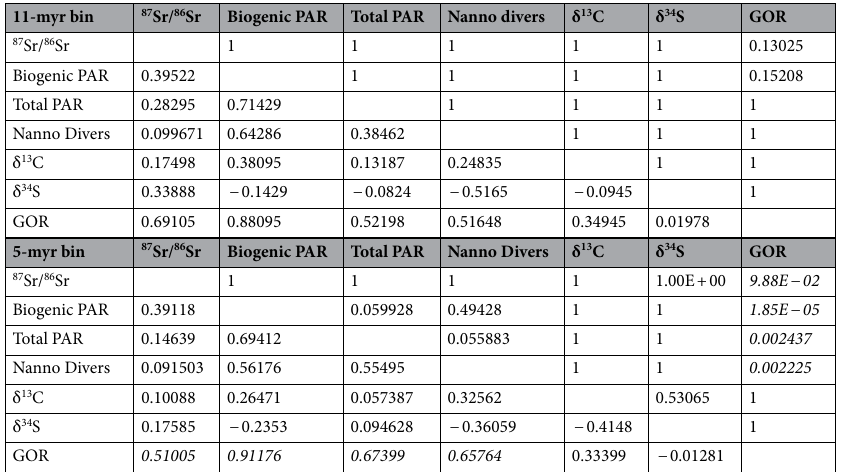
Table 2. Comparison of correlations omitting CO 2 and sea level using Bonferroni correction*. *Bonferroni correction set to p < 0.0024 (see Methods). Upper half of each binning method (above diagonally-arranged blank boxes): p (uncorrelated); lower half: Spearman’s correlation coefficient (ρ). Italics: significant correlations ( p <